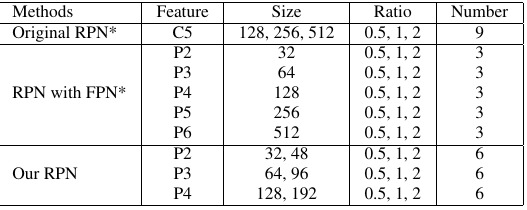
Figure 4. Instances of both positive (a) and negative (b) hard example patches in our